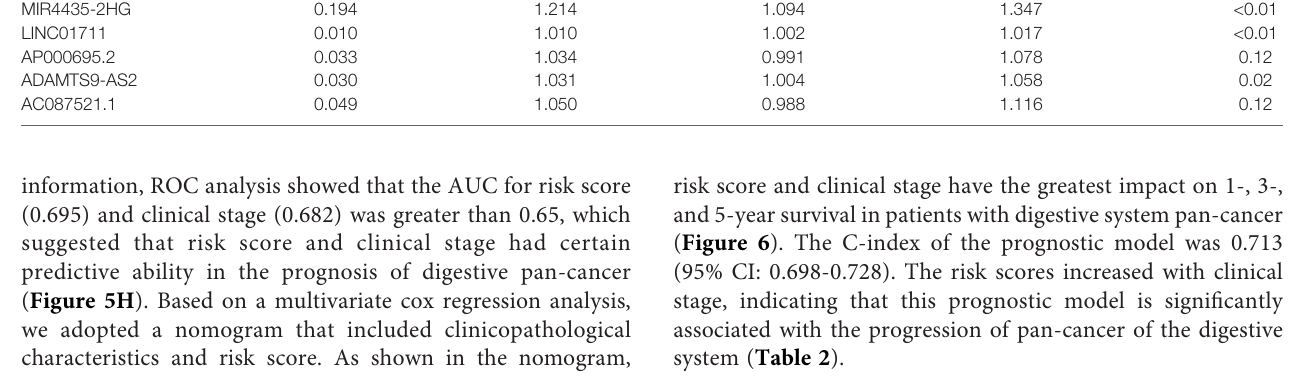
TABLE 1 | the correlation coeffcients for six HRlncRNAs gaind by multivariate cox analysis. lncRNA coef HR HR.95L HR.95H pvalue